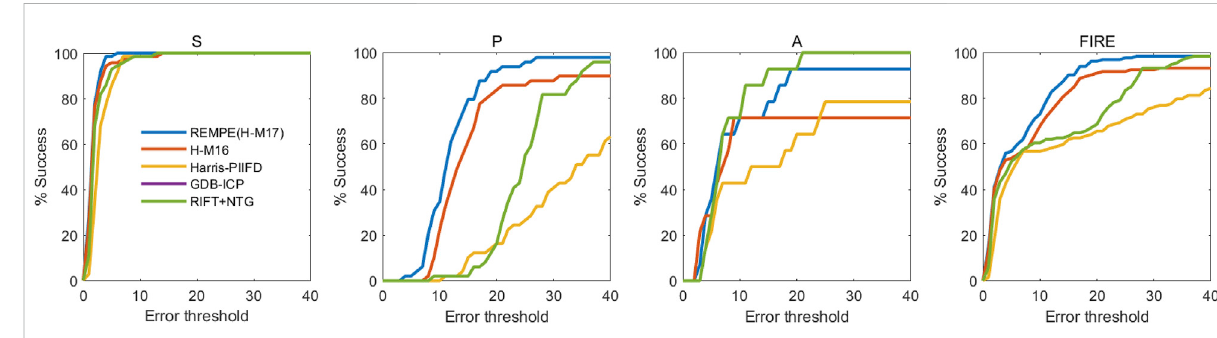
FIGURE 4 Registrationsuccessplotofthecomparisonsbetweentheproposedandotherregistrationmethods.The x -axismarks,inpixels,theregistration error threshold under which registration is considered to be successful. The y -axis marks the percentage of successfully registered image pairs for a given threshold.